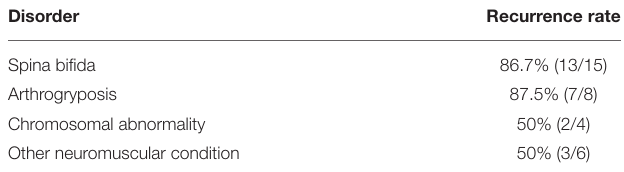
TABLE 3 | Recurrence rate by etiology.